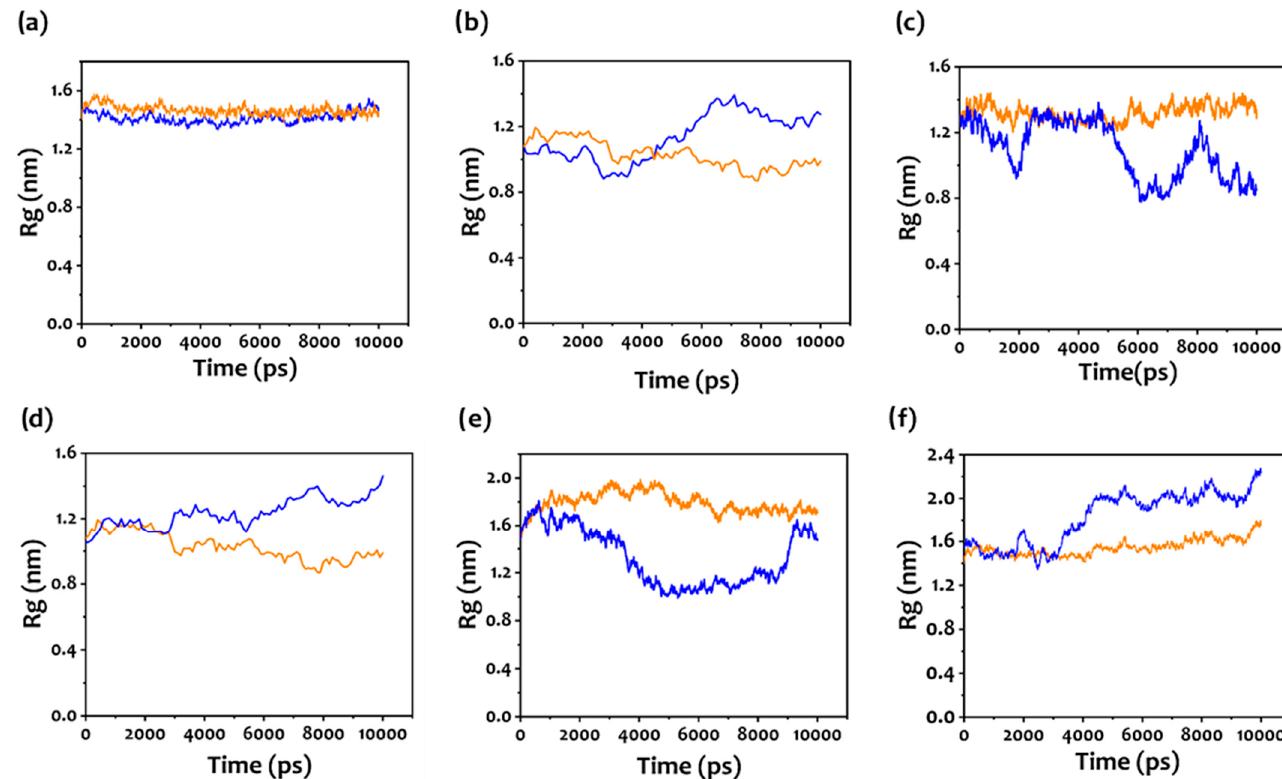
Figure 5. ( a – f ) The radius of gyration (Rg) for the different aptamers with (blue) and without (orange) the target molecule (NH 4+ ); ( a ) Control aptamer, ( b ) aptamer 1, ( c ) aptamer 2, ( d ) aptamer 3, ( e ) aptamer 4, and ( f ) aptamer 5.